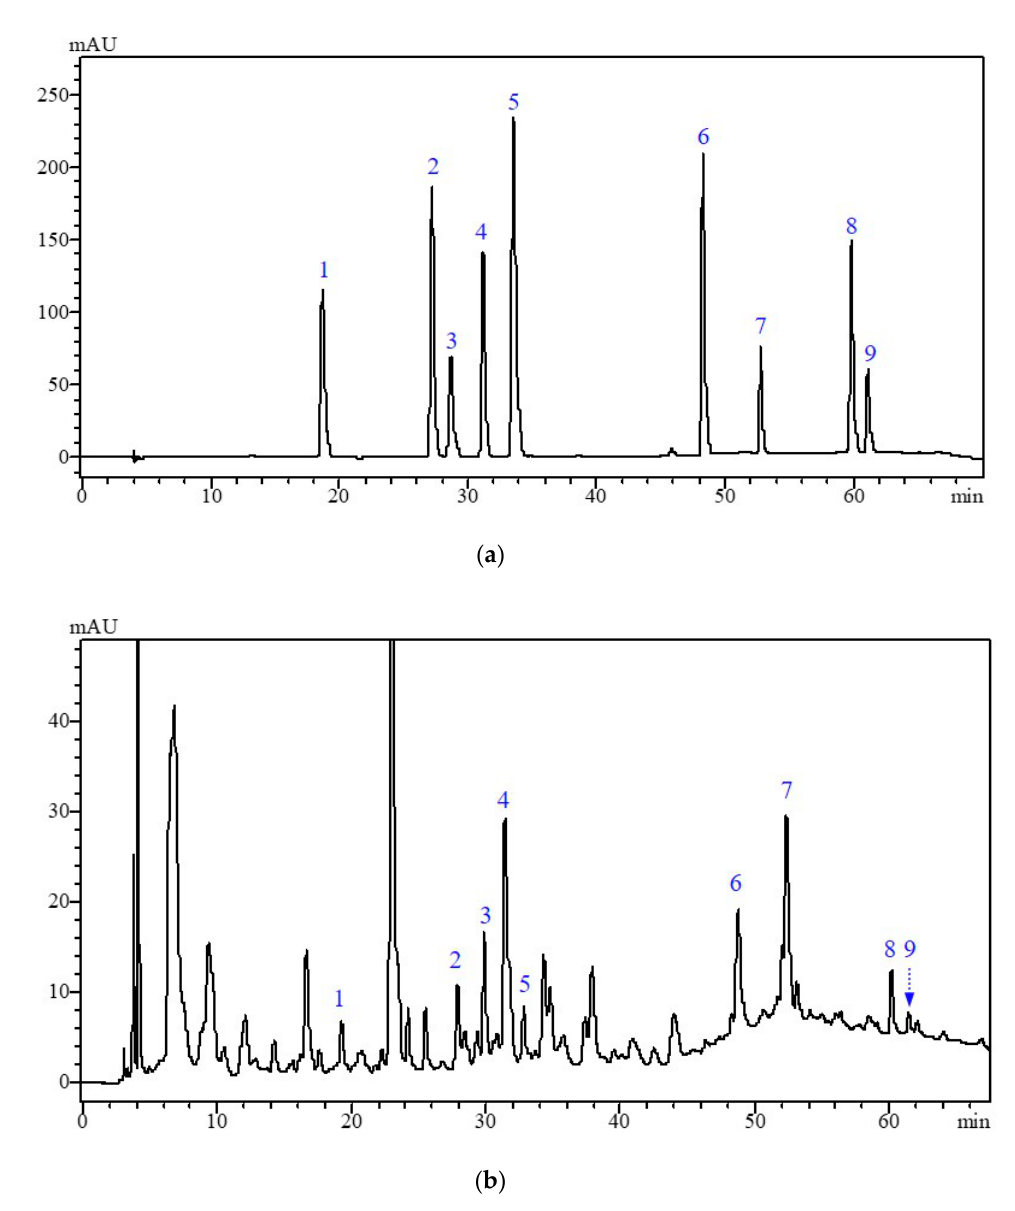
Figure 4. HPLC-PAD chromatograms of phenolic standard ( a ) and individual phenolic compounds from broccoli ( b ) at 280 nm. Peaks 1, 2, 3, 4, 5, 6, 7, 8, and 9 represent catechin, hydroxybenzoic acid, chlorogenic acid, caffeic acid, ferulic acid, sinapic acid, rutin, cinnamic acid, and quercetin, respectively.